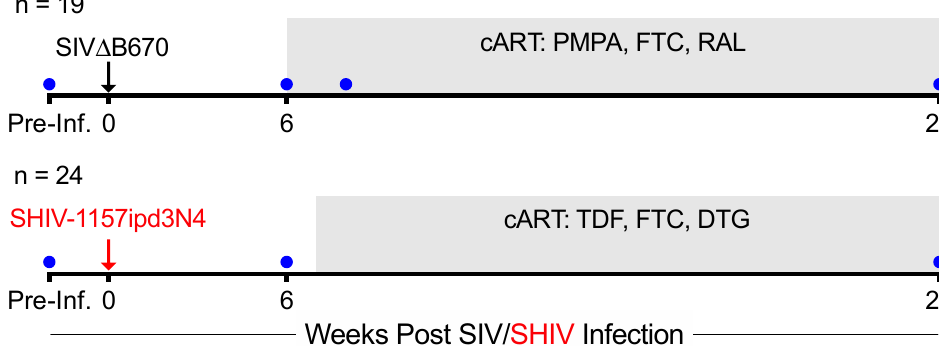
Figure 1. Study Design. Rhesus macaques were infected intravenously (i.v.) with SIV Δ B670 ( n = 19) or SHIV-1157ipd3N4 ( n = 24). Animals received daily cART starting 6 (SIV) or 7 (SHIV) weeks post-infection and consisted of injectable PMPA, FTC and oral RAL (SIV) or injectable TDF, FTC, and DTG (SHIV). Blood was collected every 1–4 weeks. Colon biopsies (blue circles) were collected pre-infection (SIV: − 4 to − 2 wpi; SHIV: − 1 to − 2 wpi), during acute infection/prior to initiation of cART (6 wpi), 2 weeks after cART initiation (8 wpi, SIV only), and at 21–22 weeks (28 wpi) after cART